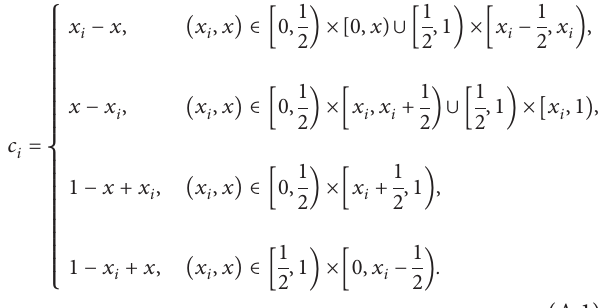
Figure 7: The graph of the function c